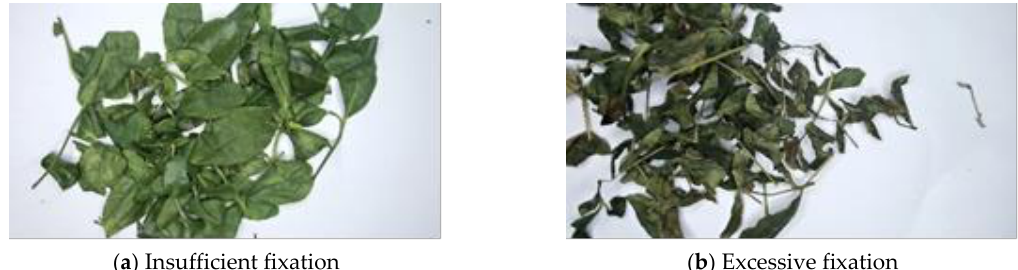
Figure 2. Regional differences in energy concentration of tea fixation image.